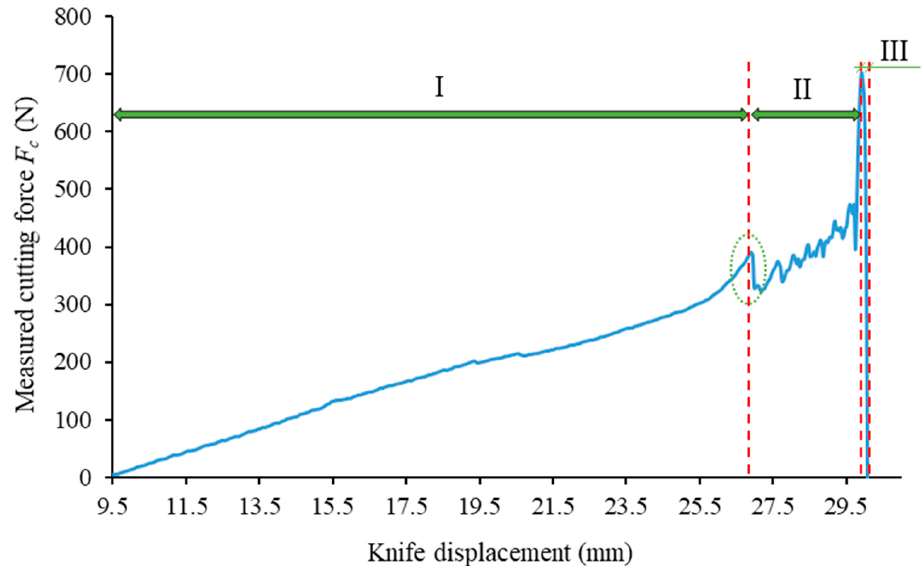
Materials 2023 , 16 , x FOR PEER REVIEW 9 of 26 Figure 4. Example characteristic curve showing the variance in the measured cutting force, F c , of the corn stalk for the parameter values: α = 40°, g = 0.1 mm and V = 1 mm/s.